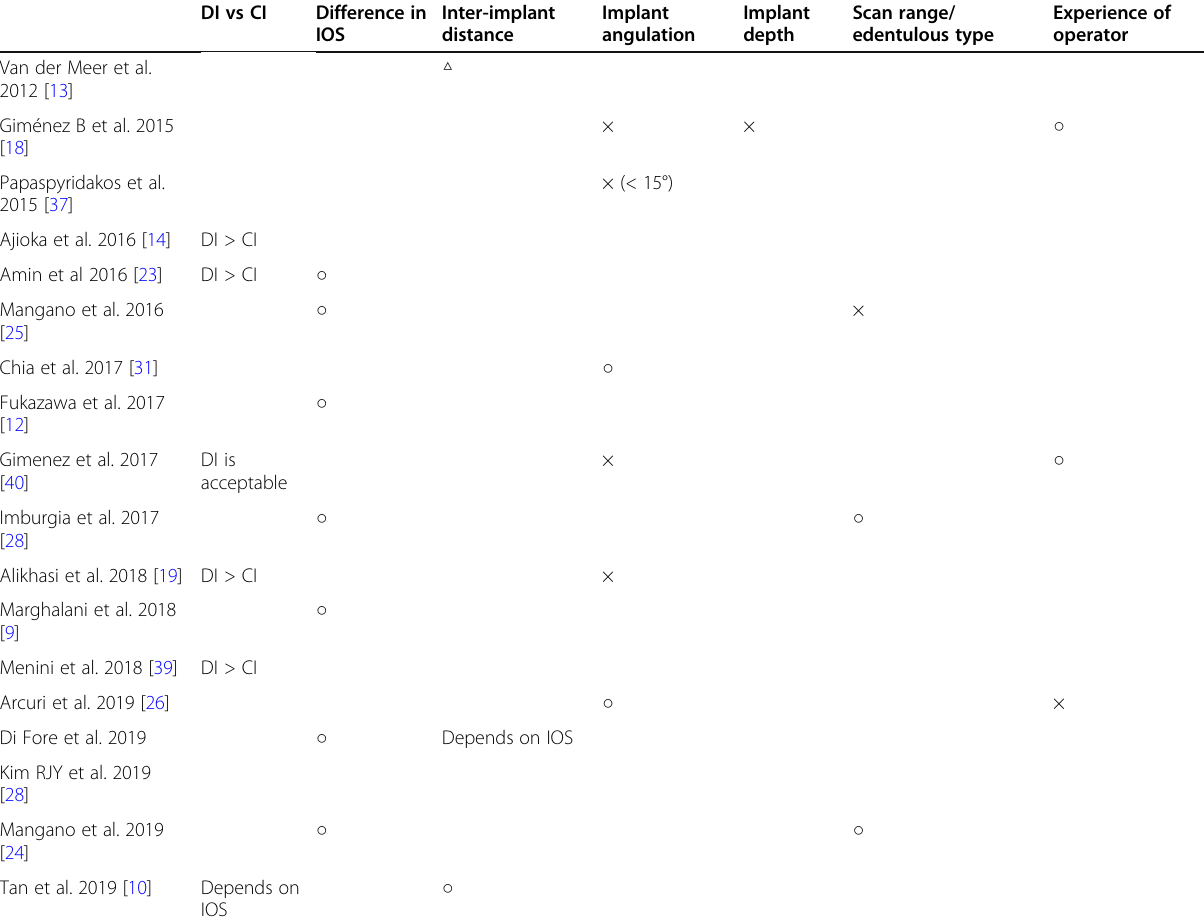
Table 7 Summary of the comparison of DI and CI, and each parameters ’ effect regarding trueness of DI. CI , conventional impression; DI , digital impression; IOS, intraoral scanner DI vs CI